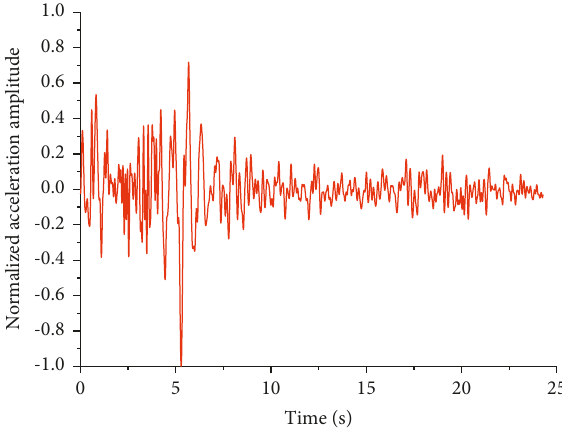
Figure 5: Time histories of normalized acceleration amplitude in a